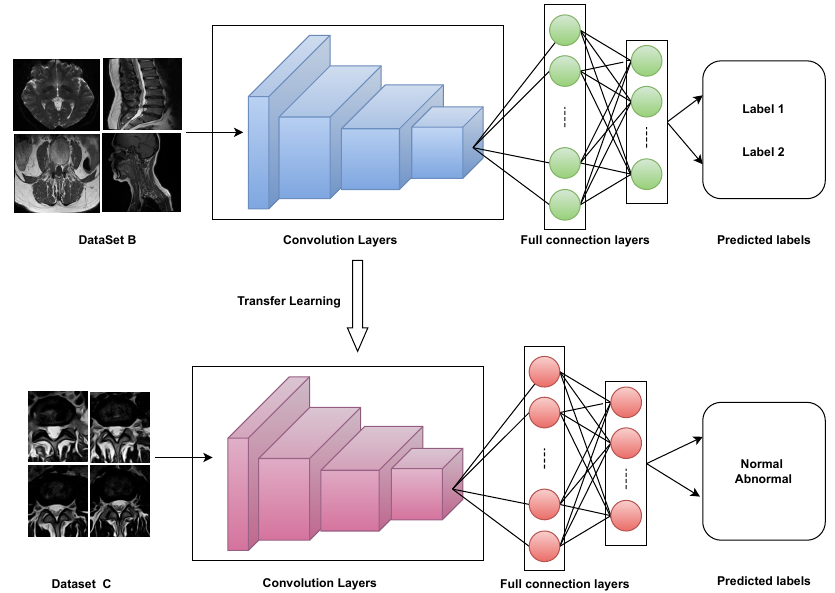
Figure 15. Transfer learning of training model from scratch with Dataset B (unlabeled MRI datasets).